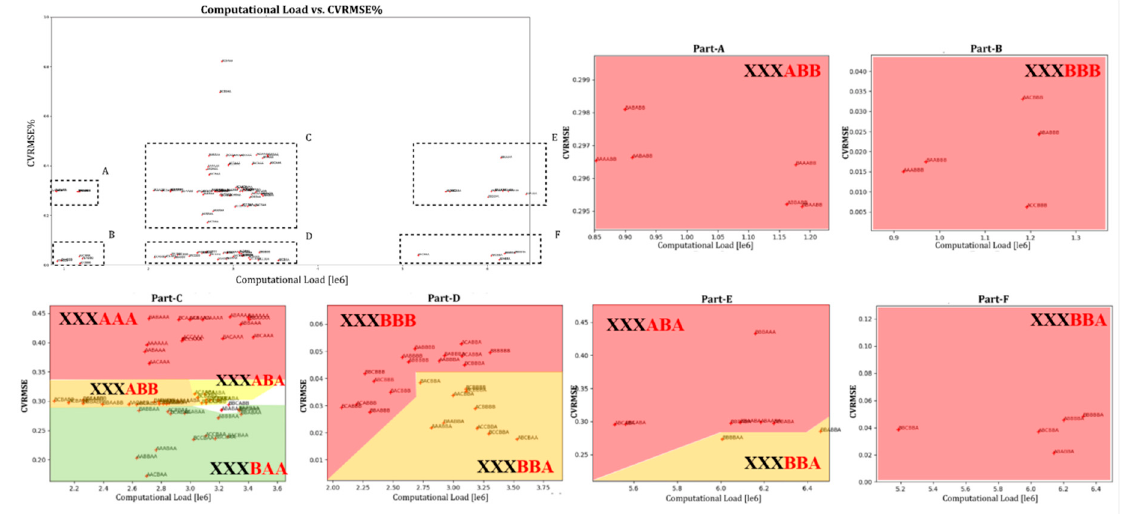
Figure 6. Computational load against CVRMSE (energy consumption).